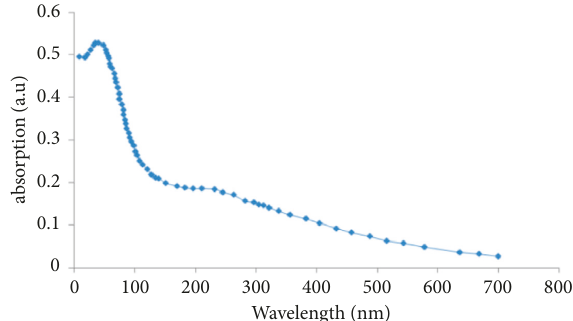
Figure 3: UV-Vis spectra of CuO NPs. Figure 4: The FTIR spectrum of CuO